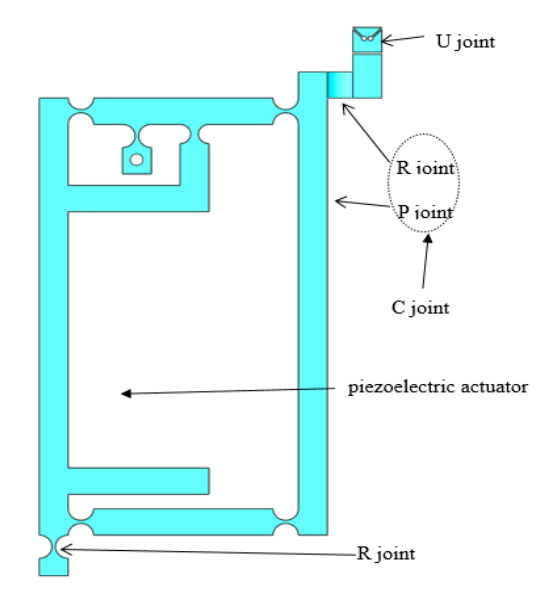
Figure 3. Single branch chain.